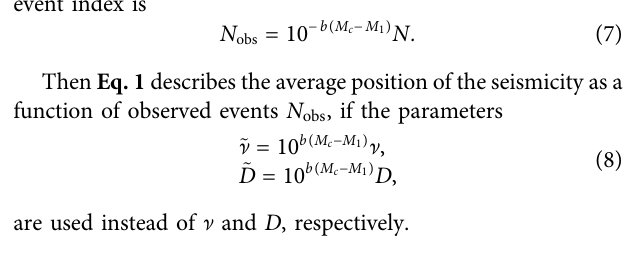
FIGURE2| Schematicillustration ofseismicity model growth supposing that a new rupture is initiated at the edge of the previous rupture. (A) The channel growth (model C) is related to a unidirectional or bidirectional 1-D advance of the rupture front. (B) The sector growth (model S) considers a 2-D advance of the rupture